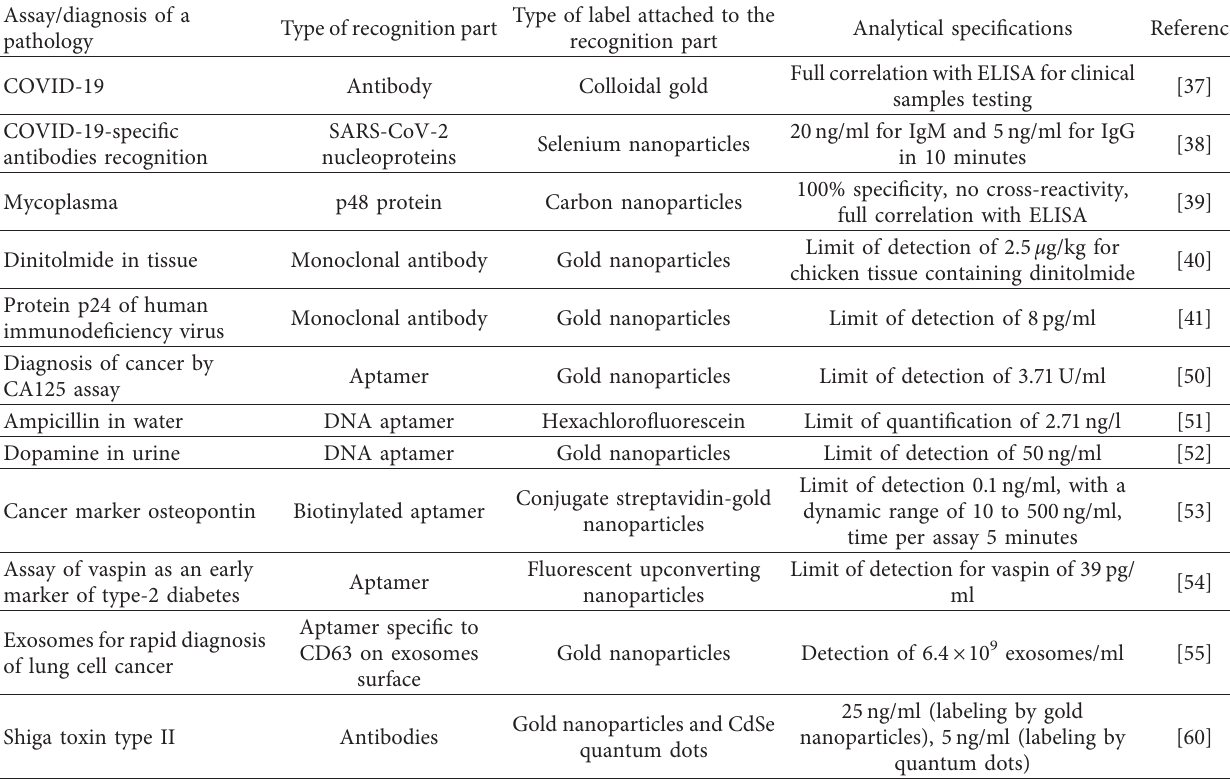
Table 1: Overview of LFT in point-of-care